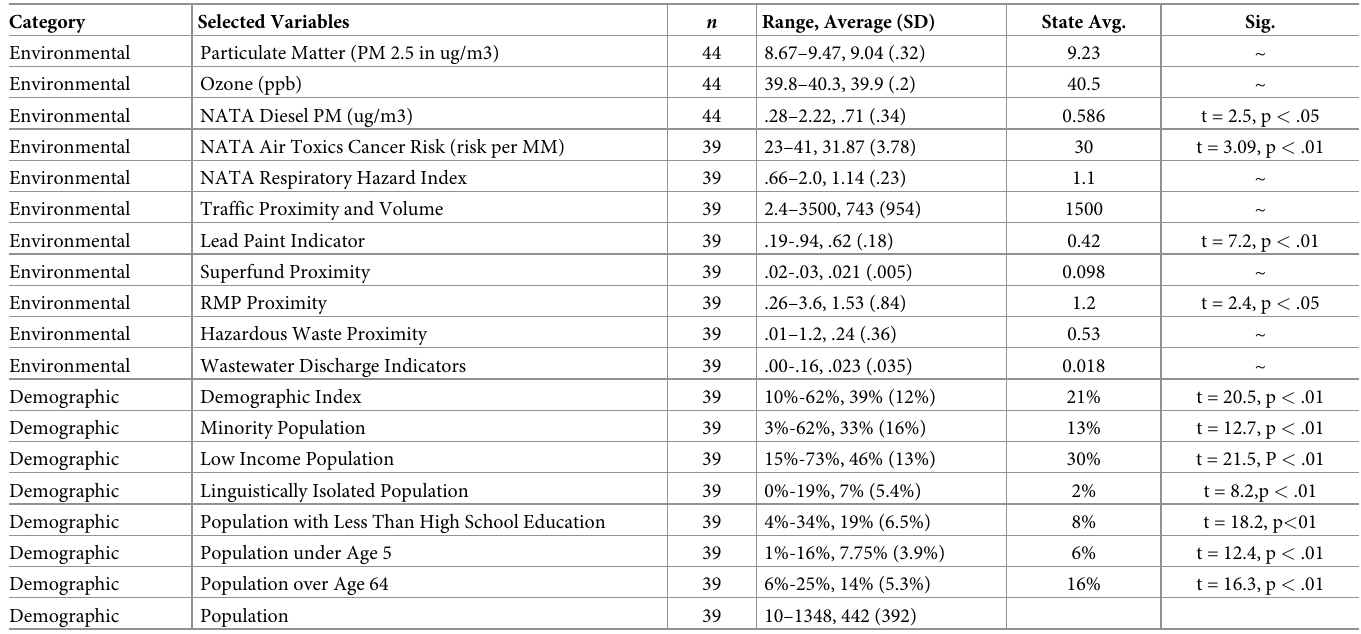
Table 3. Variables downloaded using EPA’s EJscreen for each 1/2 mi. transect point.